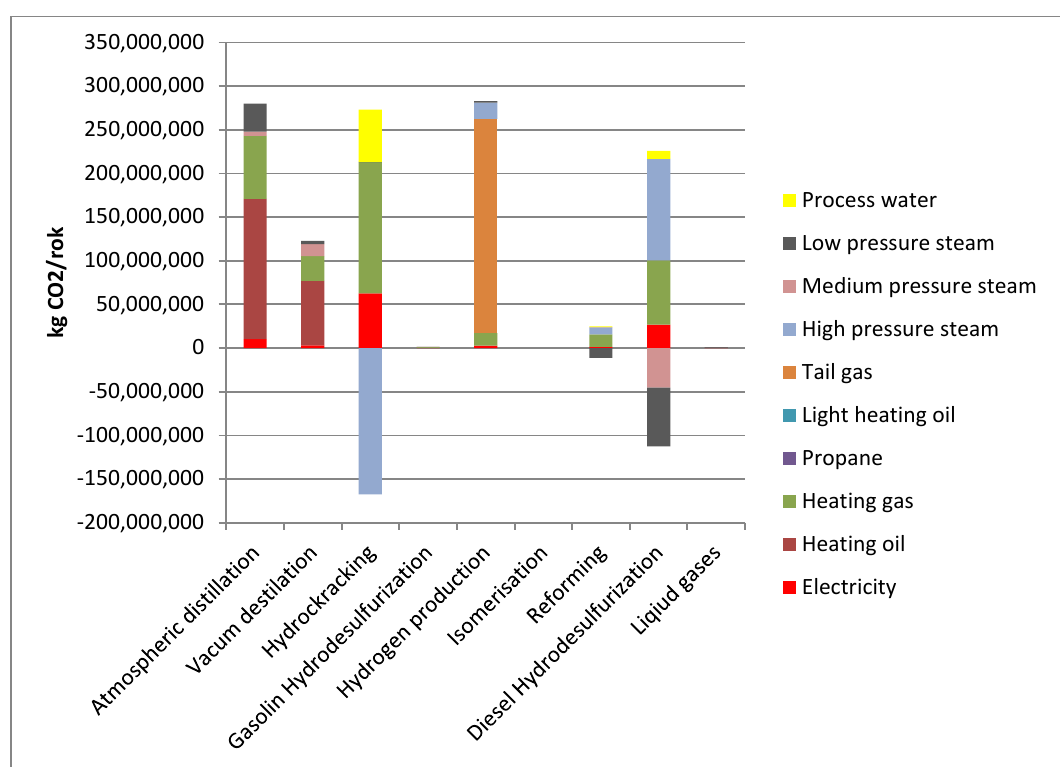
Figure 5. Annual GHG emissions generated by individual installations after allocation to diesel.